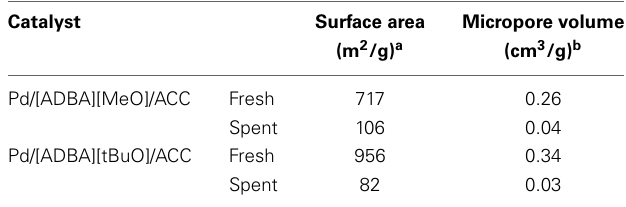
Table 1 | Results from the nitrogen physisorption measurements.